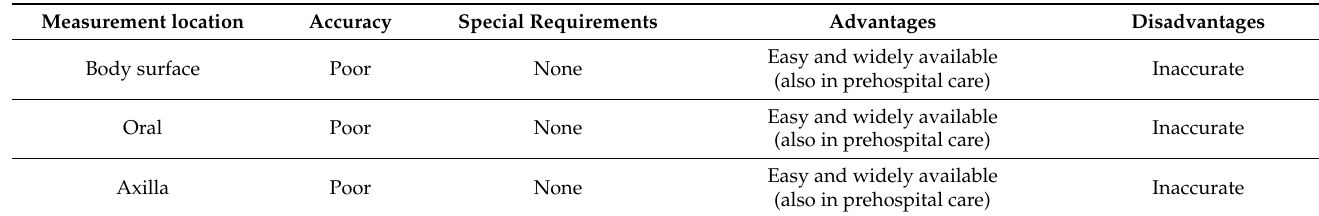
Table A1. Summary of temperature